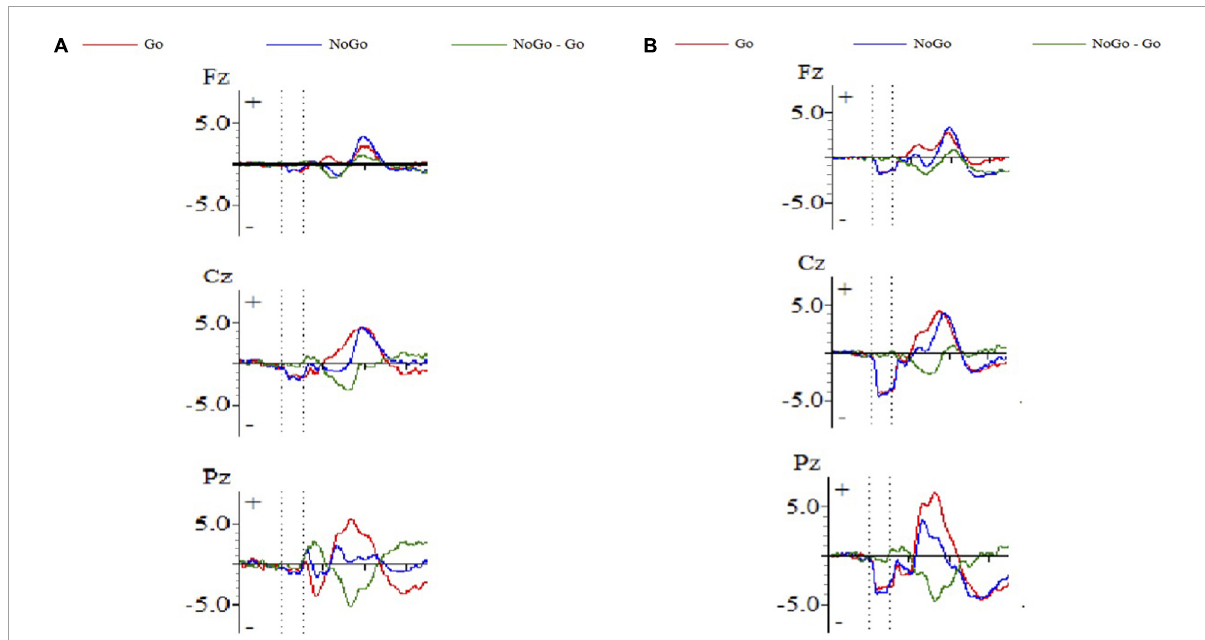
FIGURE1 The ERP waveform diagram of Fz, Cz, and Pz. (A) High self-efficacy group; (B) low self-efficacy group. The red line represents the waveform result of the Go trials, and the blue line represents the waveform result of the No-Go trials.